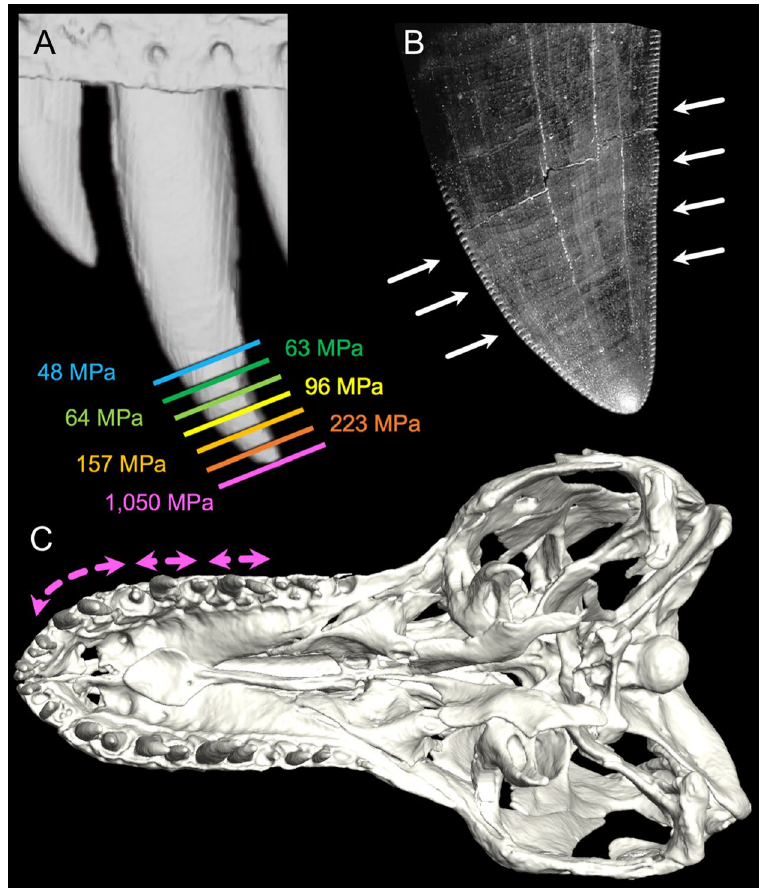
Figure 3. Tyrannosaurus rex dental functional morphology. ( A ) Exemplar tooth pressures along the distal 37 mm of the left M5 of BHI 3033 (warmer colours indicate higher pressures), illustrating bone-penetrating shear stresses ( > 65 MPa 4, 39 ) for almost 25 mm of indentation depth. ( B ) Mesial and distal facing carinae (white arrows) helped direct pathways of bone fracture towards adjacent maxillary teeth ( C ) (ventral view of BHI 3033) that were also engaged during indentation, illustrating how the most procumbent maxillary tooth crowns collectively form a fracture arcade (pink arrows) due to pressures generated when biting. (Figure element in ( A ) derived from digital scan by Virtual Surfaces,